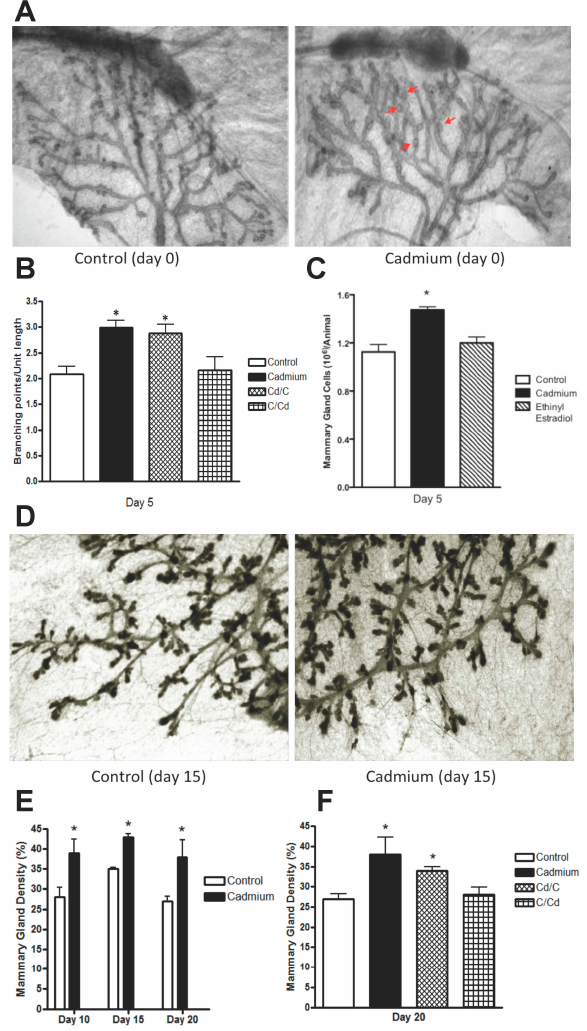
Figure 2. Effects of in utero exposure to cadmium on the morphology of the mammary gland of female offspring. Pregnant female rats were treated with cadmium (5 µ g/kg bw) or ethinyl estradiol (50 µ g/kg bw) and the female offspring were crossfostered as described in Figure 1. Cadmium treated animals were exposed to cadmium while in utero and during lactation; Cd/C treated animals were exposed to cadmium while in utero ; and C/Cd treated animals were exposed to cadmium during lactation. For morphological analyses, the fourth abdominal mammary glands were excised. ( A ) In utero effects on mammary gland morphology. Digital image on postnatal day 0 from a control animal (representative image) or an animal exposed to cadmium (representative image). Arrows indicate abnormal lateral budding; ( B ) in utero effects on mammary gland branching. The number of branch points was quantified on postnatal day 5 as branches per unit length (mean ± SEM; n = 3 offspring/group; * p < 0.05); ( C ) in utero effects on the number of epithelial cells in the mammary gland. Both fourth abdominal mammary glands were excised on postnatal day 5. Epithelial cells were isolated and counted (mean ± SEM; n = 4 offspring/control group, n = 3 offspring/cadmium group, n = 2 offspring/ethinyl estradiol group; * p < 0.05 for control vs. cadmium). ( D – F ) In utero effects on mammary gland density on postnatal days 10, 15, and 20; ( D ) digital image from 15-day-old control animal (representative image) or animal exposed to cadmium (representative image); ( E , F ) mammary gland density is expressed as the percent of epithelium in the fat pad (mean ± SEM; n = 3 offspring/group; * p < 0.05). Digital images of control offspring on postnatal days 0 and 15 were adapted with permission from Reproductive Toxicololgy